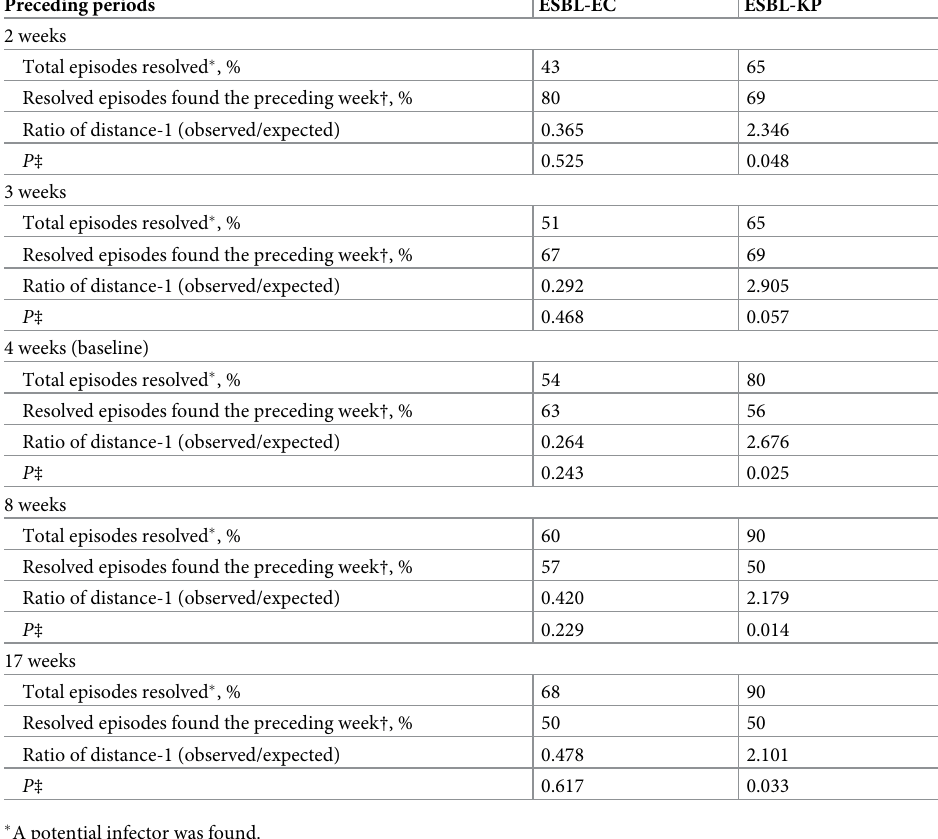
Table 3. Sensitivity analyses of 2-, 3-, 8- or 17-week windows of investigation compared to baseline for transmis- sion candidates. Preceding